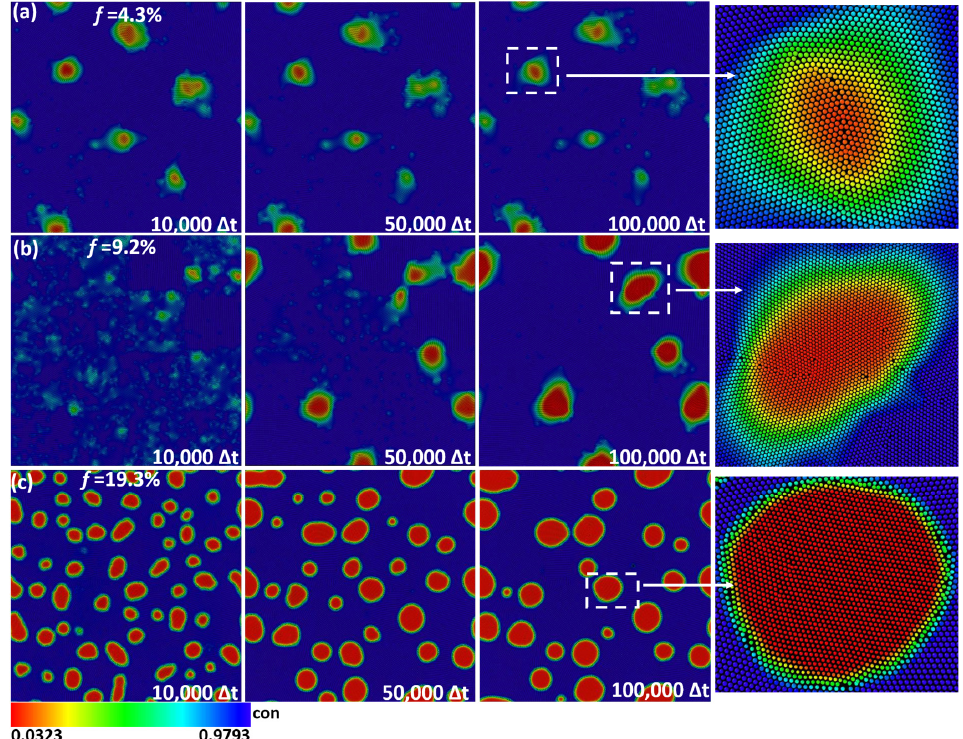
Figure 1. The evolution of precipitation process with different lattice misfits: ( a ) f = 4.3%; ( b ) f = 9.2%; ( c ) f = 19.3%. The deformation simulations are conducted after 100,000 Δ t, as shown in the Videos S1–S3 in the Supplementary Materials. Note that the “con” on the right side of the color bar is the abbreviation for concentration.